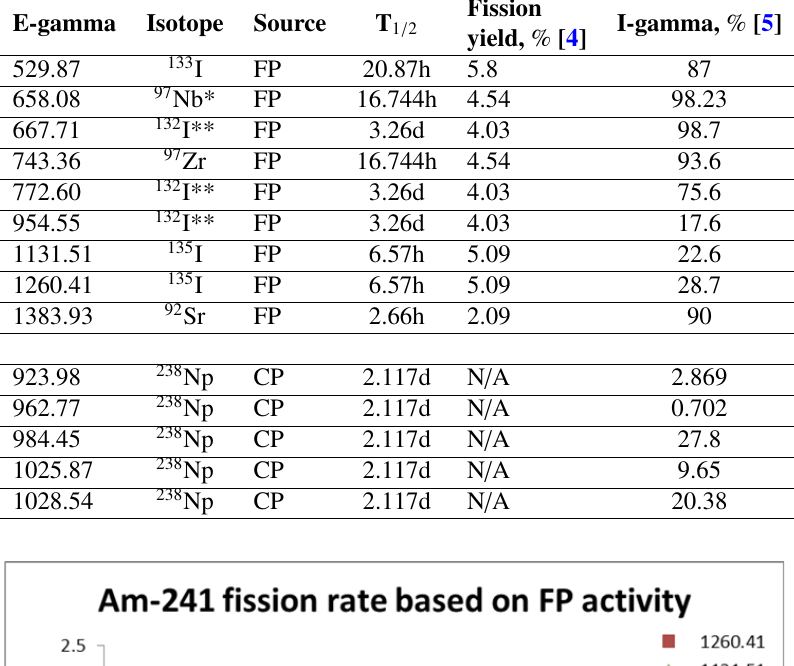
Table 1. Sample Am-241-identified gamma lines and their